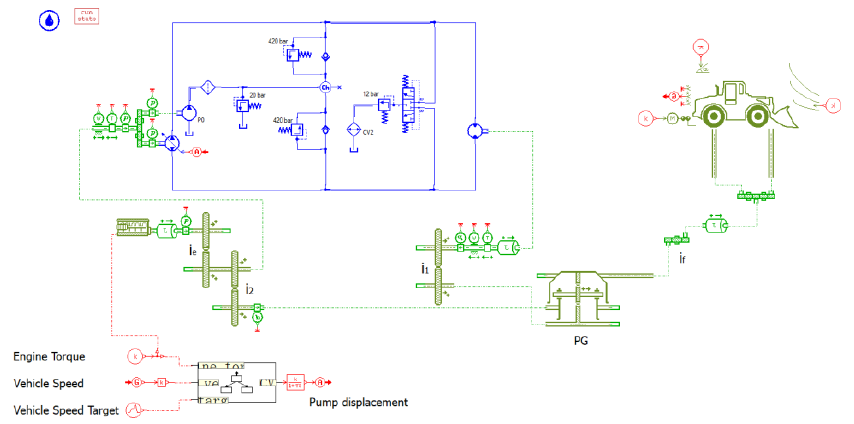
Figure 19. Simulation model of HM1 range.